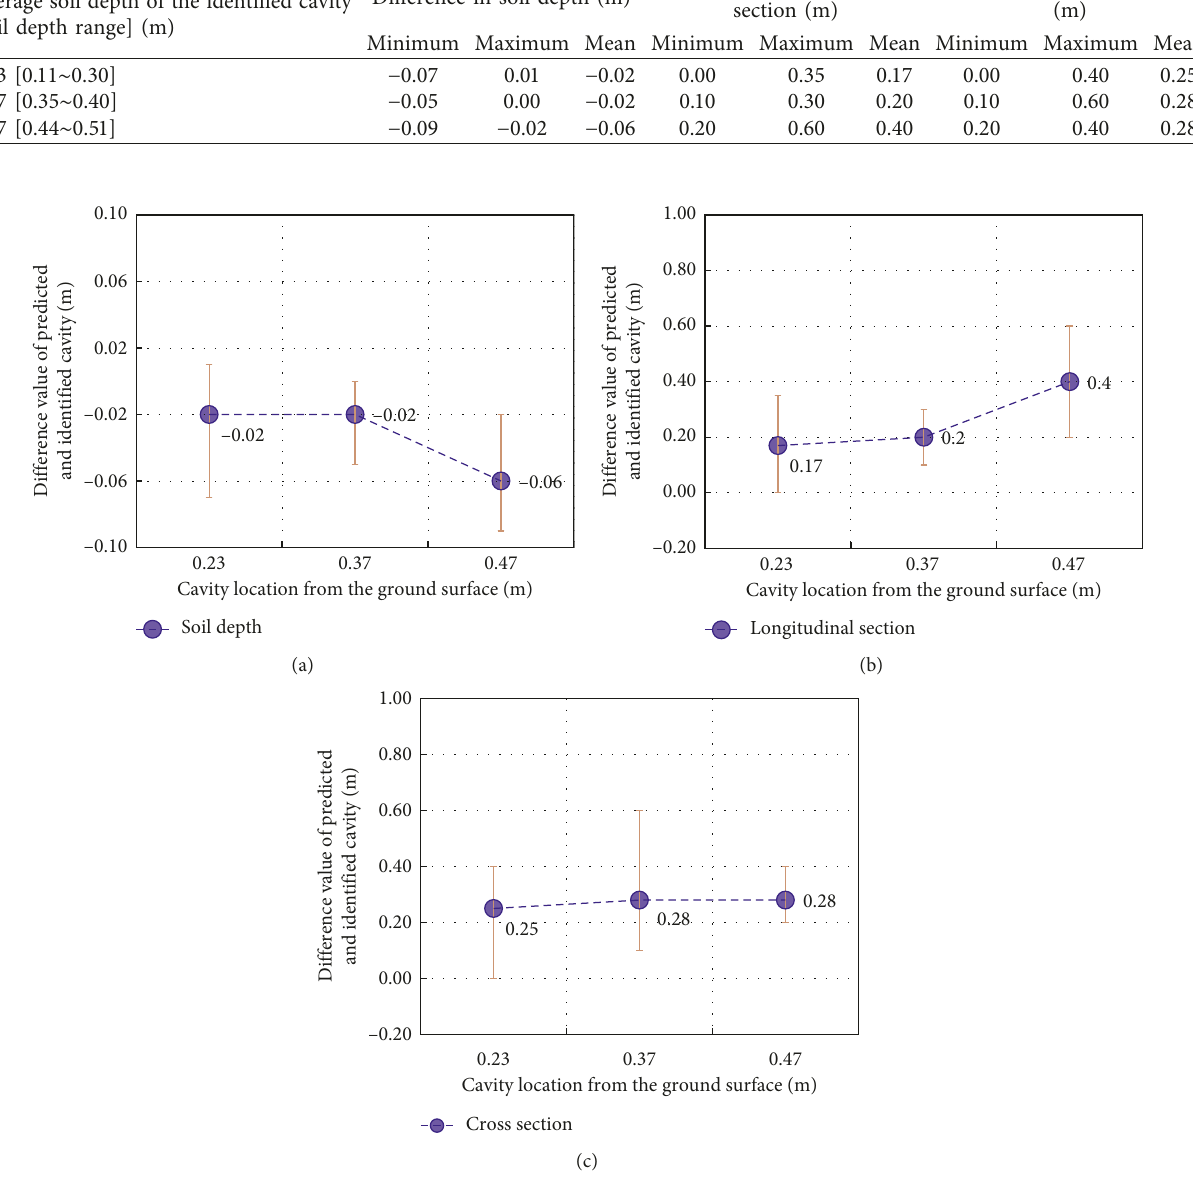
Difference in longitudinal Difference in cross section Difference in soil depth (m) section (m)